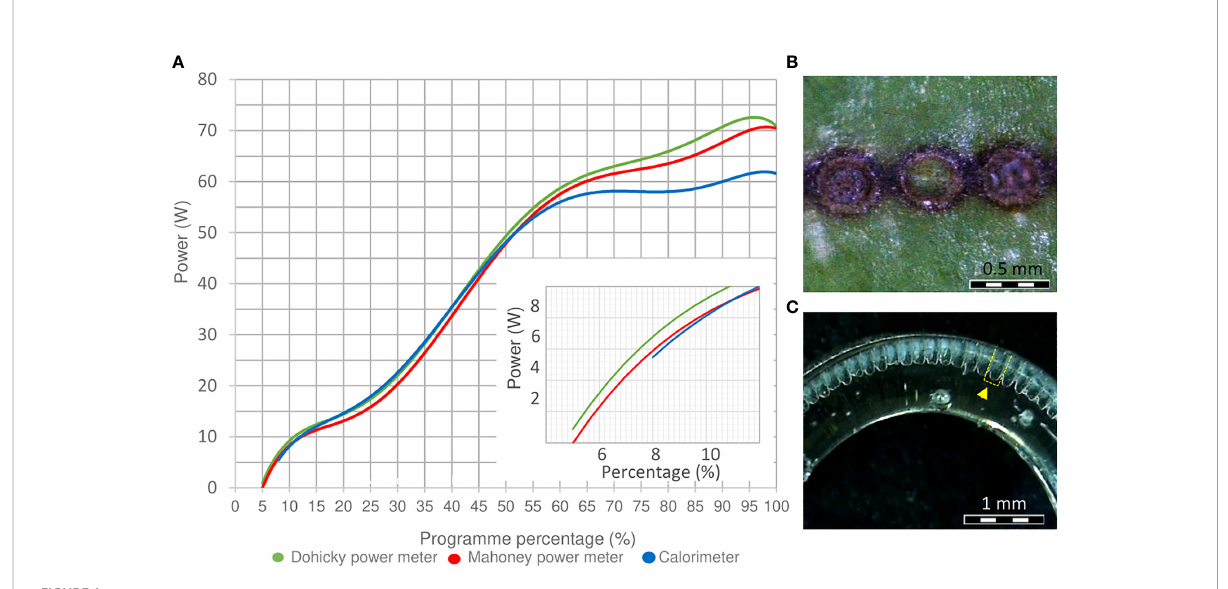
FIGURE 1 Power, beam size and beam pro fi le determination. (A) Power determination of the laser equipment measured by a calorimeter J22201, a Mahoney, and Dohicky power meter. An enlarged section from 0 to 12% laser power is included at the corner of the diagram. (B) Beam size of a laser dot on the surface of a R. canina ‘ Pfänder ’ cutting. (C) Performance of a fl ap top beam pro fi le (yellow marked) on a PMMA cylinder 7 mm outside and 5 mm